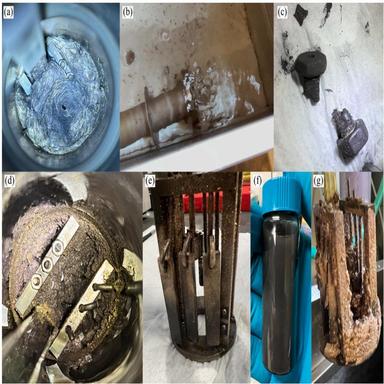
Images of the cleaning process for the aluminum bronze samples. (a) Slag formed on the top of the lithium after removing from the experiment and exposing to air. (b) Reaction of lithium in canister with the cleaning water. Particulates are seen flowing from the canister immediately. (c) Bolt sample broken into two pieces after removal. (d) Corrosion products left in the canister after water cleaning. These products were granular and the sample stand could be removed. (e) Sample stand was covered with corros